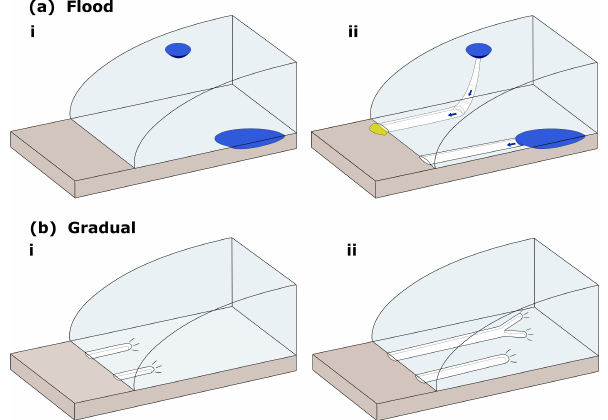
Figure 1. Cartoons depicting the two main models for tunnel valley formation: (a) outburst floods from supraglacial and/or subglacially stored water; and (b) gradual headward growth by